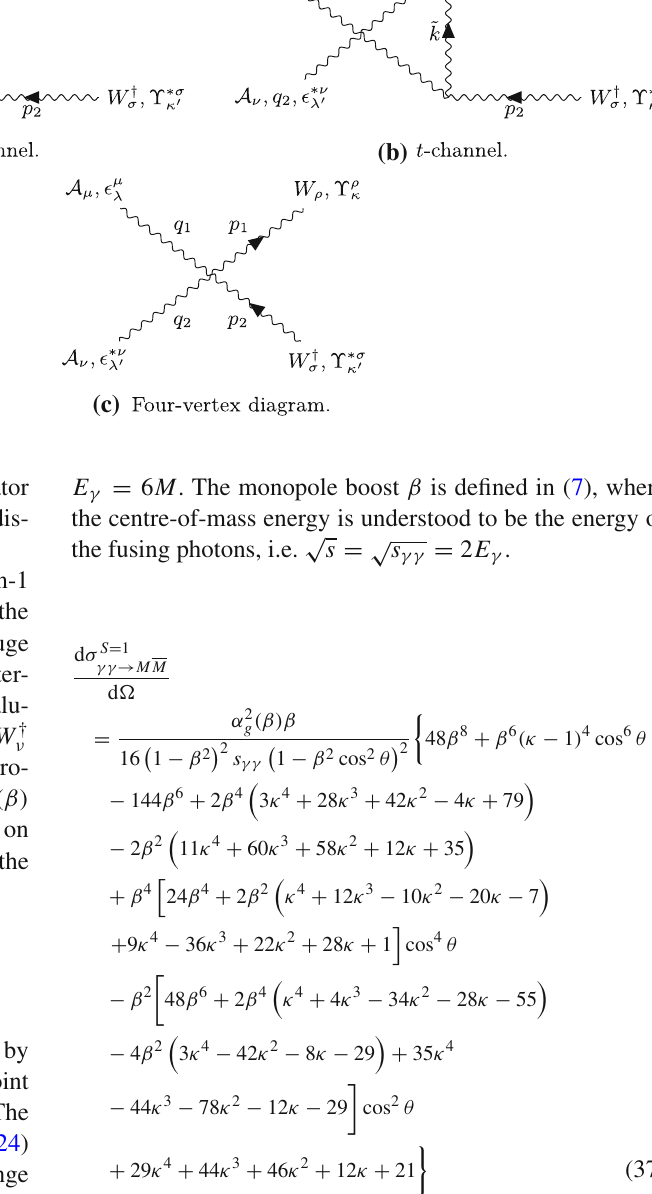
Fig. 14 Feynman-like diagrams for the t -channel ( a ), u -channel ( b ) and seagull diagram ( c ) that contribute to the production of a vector-monopole pair, WW † , from the fusion of two gauge bosons. The variable definitions are given in the